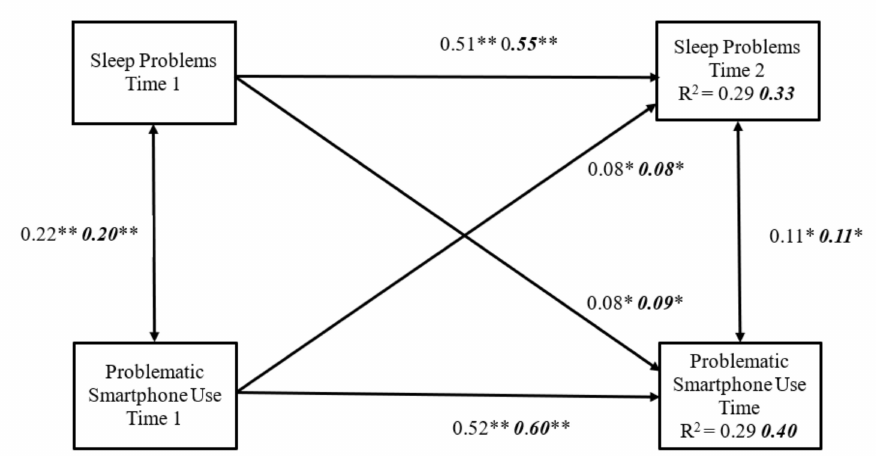
Figure 2. The cross-lagged model with bidirectional effects between sleep problems and problematic smartphone use between sexes. The model controlled for school types, parents’ education level, and parents’ job status. The coefficients in regular print and those in bold italics, represent, respectively, the results for the male and the female samples. ** p < 0.001, * p <